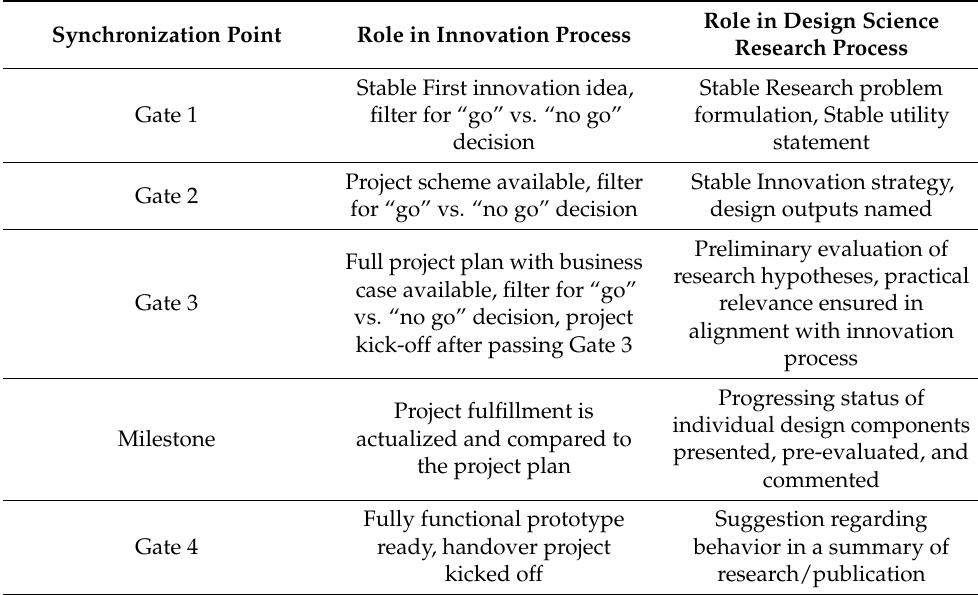
Table 2. The Synchronization Points between Innovation Process and Design Science Research (DSR)